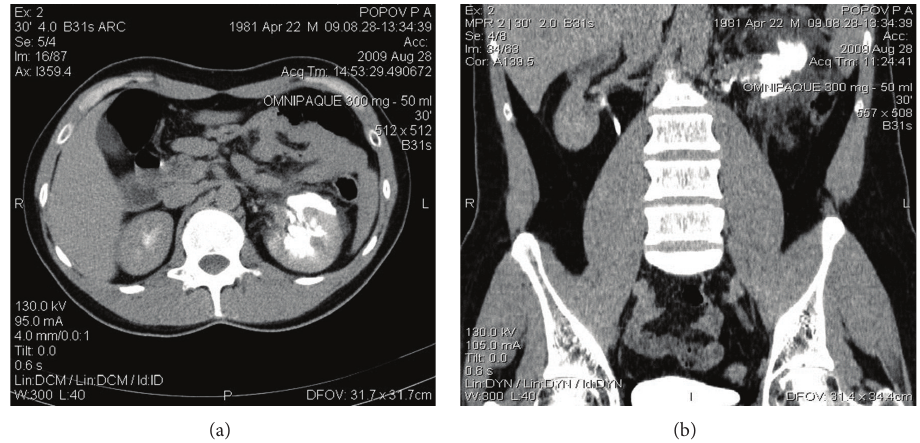
Figure 1: Computed tomography showing extravasation of the contrast medium through the gap in pelvis—spontaneous rupture. Axial (a) and sagittal (b) images.